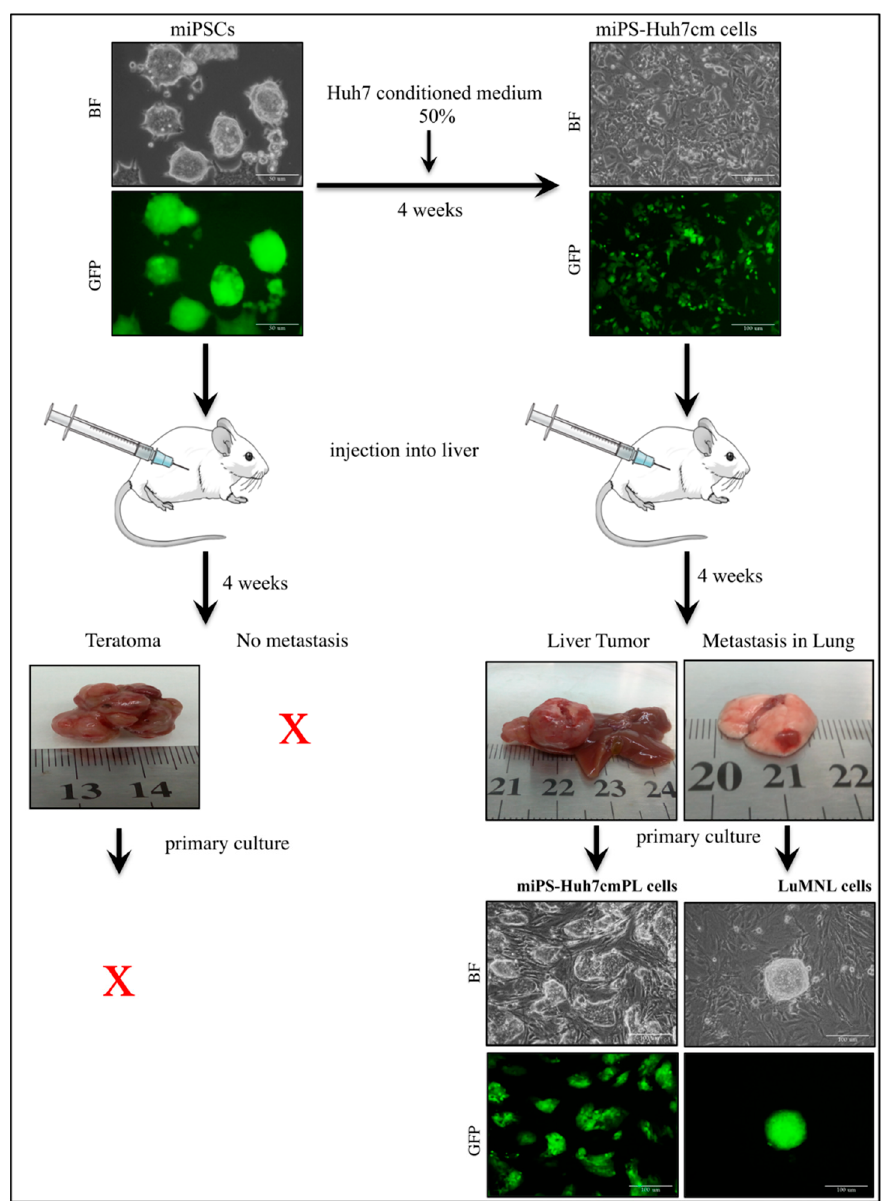
Figure 1. This representative image shows the conversion of mouse induced pluripotent stem cells (miPSCs) into cancer stem cells (CSCs) in the presence of Huh7 cells conditioned medium (CM) and shows the appearance of an orthotopic malignant tumor in the liver, with lung metastasis from miPS-Huh7cm cells, whereas miPSCs formed teratomas after 4 weeks. Scale bars represent 50 µ m. The primary cultures from the malignant tumor and lung metastasis showed green fluorescent protein (GFP)-expressing cells indicating the injected cells, whereas primary cells from teratoma cannot survive. Scale bars represent 100 µ m.